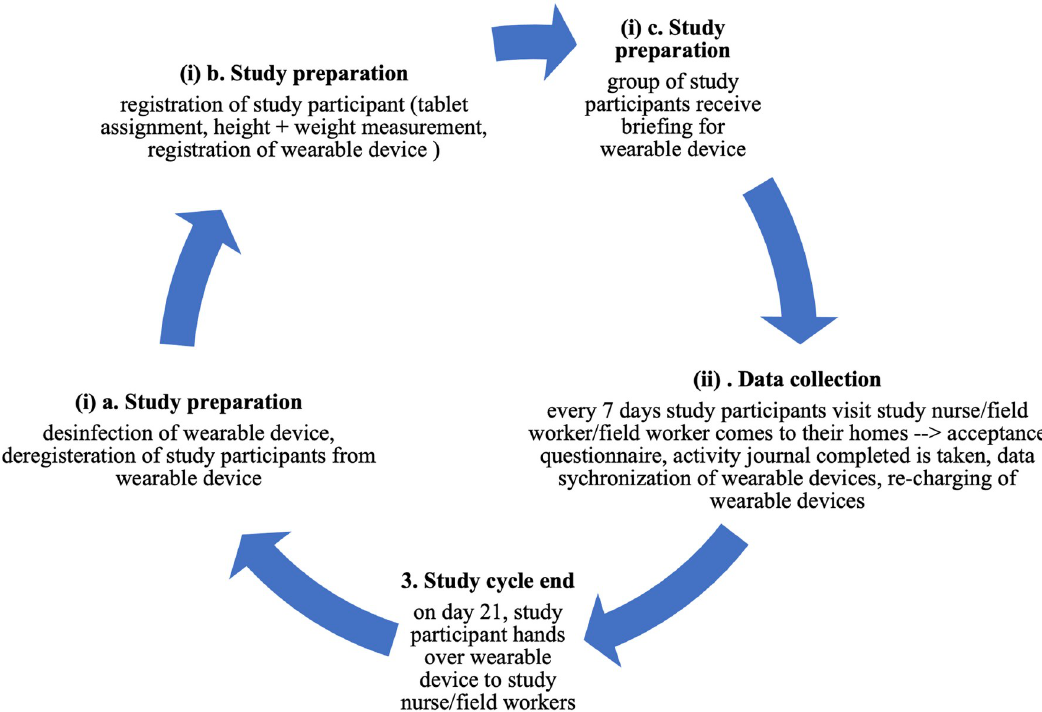
Fig 1. Overview cycle of wearable device feasibility study. The study cycle depicts the individual steps that are conducted, whereby a total of three study cycle will be conducted that comprise each n = 50 study participants.